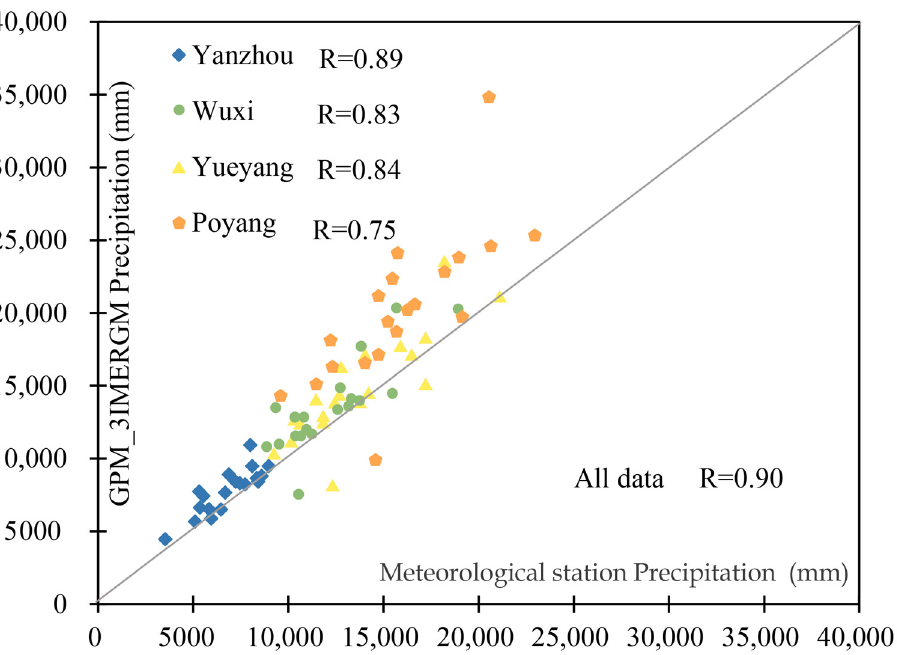
Figure 11. Comparisons of meteorological annual precipitation and GPM IMERG precipitation (note, the gray line represents the 1:1 line).